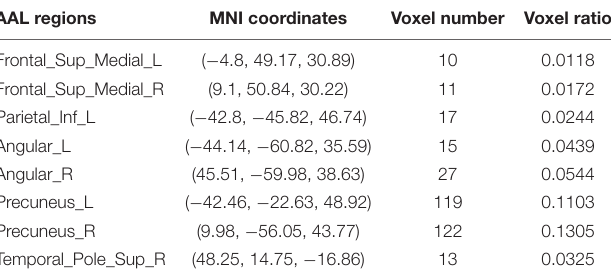
TABLE 2 | The statistical distribution of activated voxels corresponding to functional connectivities (FCs) with significant differences between the seafarer and non-seafarer groups in the Anatomical Automatic Labeling (AAL) brain regions as well as the Montreal Neurological Institute (MNI)